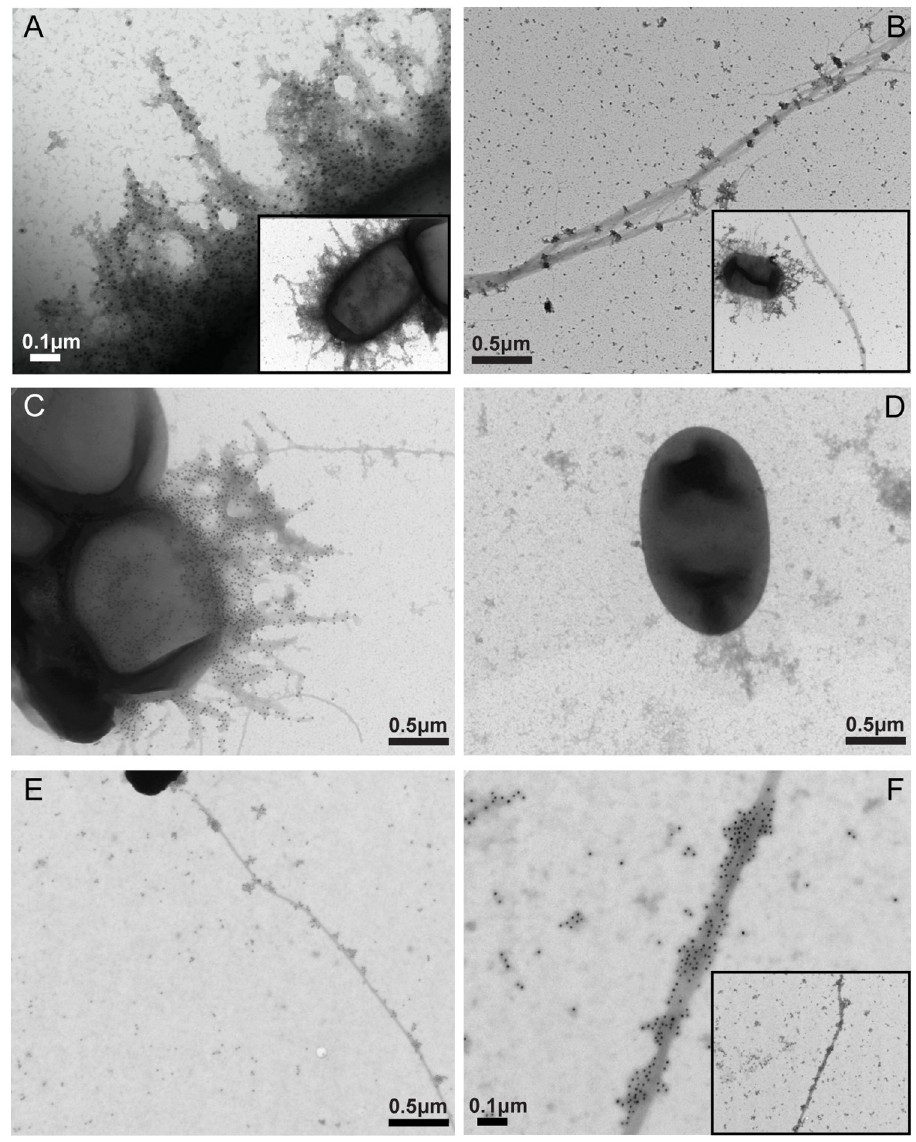
Fig 3. Expression of CFA/I and CS21 on wildtype ETEC strains using immunogold electron microscopy. Bacteria and CFs were visualized by TEM following immunogold staining with CF-specific antibodies. Wildtype strain CVD30 (A, B) was stained with anti-CFA/I antibodies (A) or anti-CS21 antibodies (B). Wildtype strain H10407 (C) and CFA/ I-deficient strain H10407Kan (D) were stained with anti-CFA/I antibodies. Wildtype strain E9034A was stained with anti-CS21 antibodies (E, F). All strains were grown on CFA agar. Scale bar size indicated in μ M. The insets in panels A and B show the whole bacterium producing the CF of interest covered with gold particles. The inset in panel F shows a lower magnification of the CS21 pili expressed by E9034A covered with gold